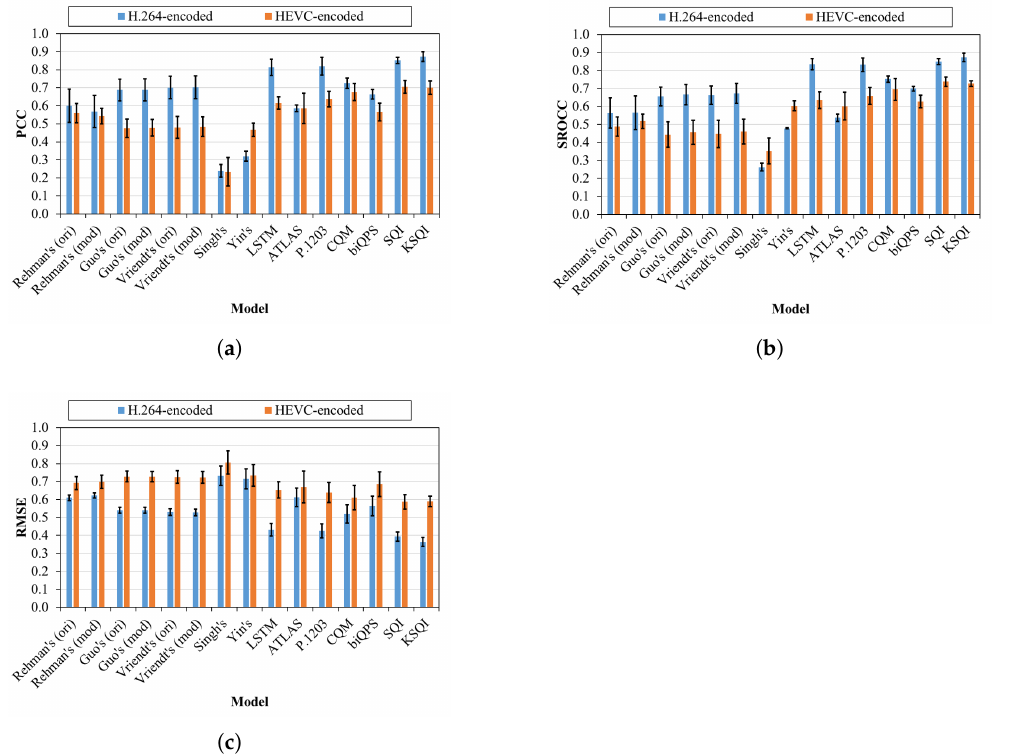
Figure 2. Average performances of individual QoE models over H.264-encoded set and HEVC-encoded set. ( a ) PCC; ( b ) SROCC; ( c )